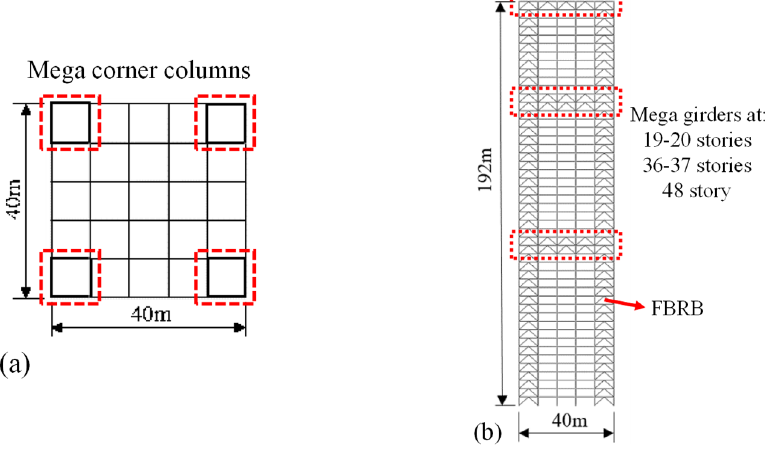
Figure 12. Plane layout and elevation of the FBRB ‐ BF structure: ( a ) plane layout; and ( b ) elevation.